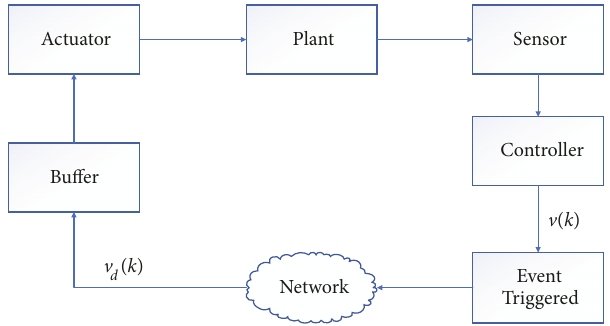
Figure 1: Frameworkof NCSs with event-triggered communication